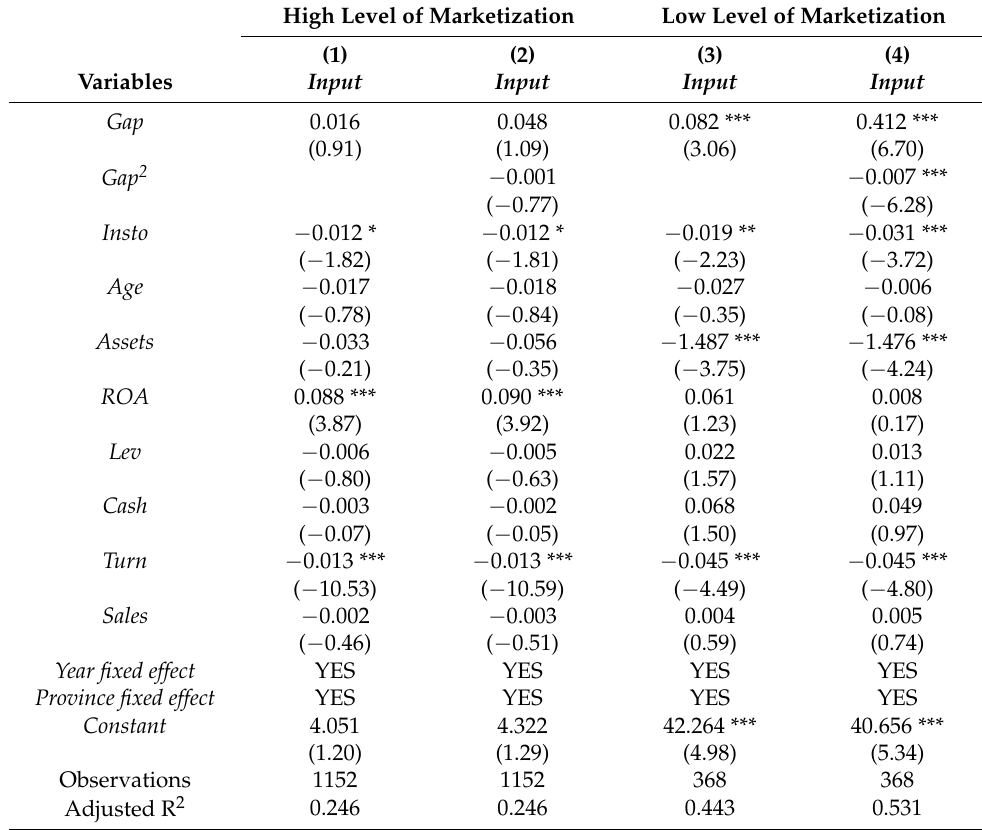
Table 6. Heterogeneity test: high level of marketization vs. low level of marketization. High Level of